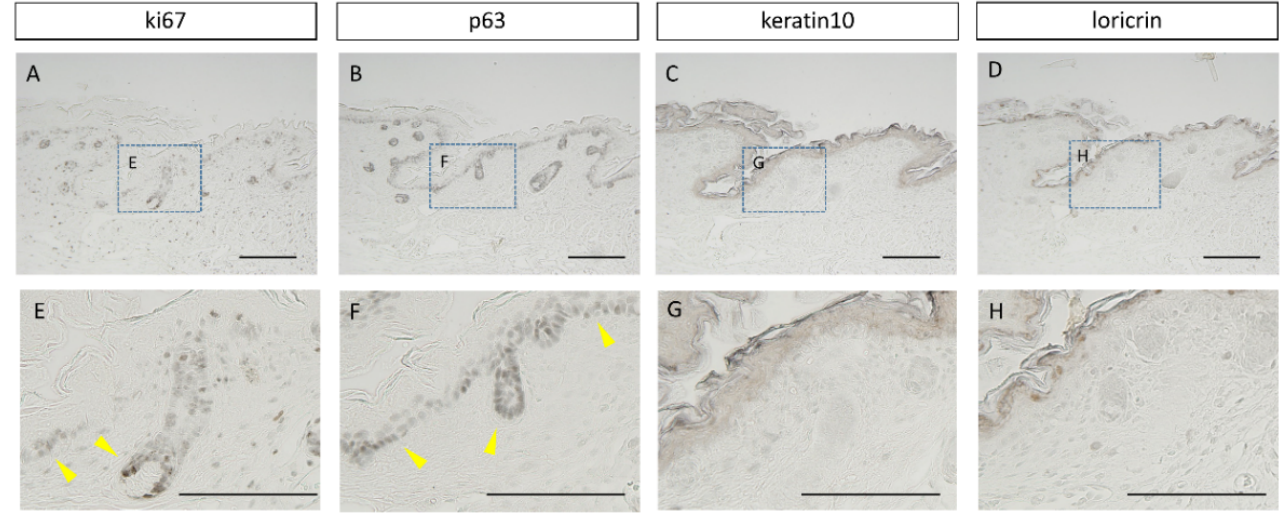
Figure 2. Relationship between cell division/differentiation and Lhx2. ( A – D ): low magnification im- ages of the wound; ( E – H ): high magnification images of the skin appendages. Lhx2-rich follicles and epidermal basal layer expressed Ki67 and p63 and actively underwent cell division. Scale bar = 100 μ m.